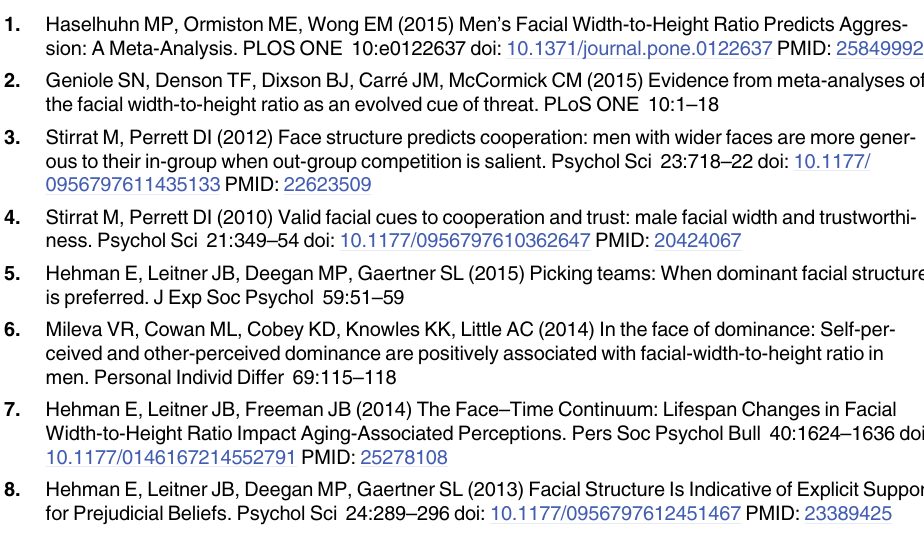
S5 Fig. Male and Female trajectories byzigomatic width (BZW) and of upper facial height (FHT). Values of upper facial height and bizygomatic width provided by FaceBase database. Weston found a significantly difference in the intercept between male and female. The graph shows the absence of this difference using these values. (TIF) S1 Text. Face stimuli and facial measures in normal population. S2 Text. Test of sexual dimorphism using FaceBase